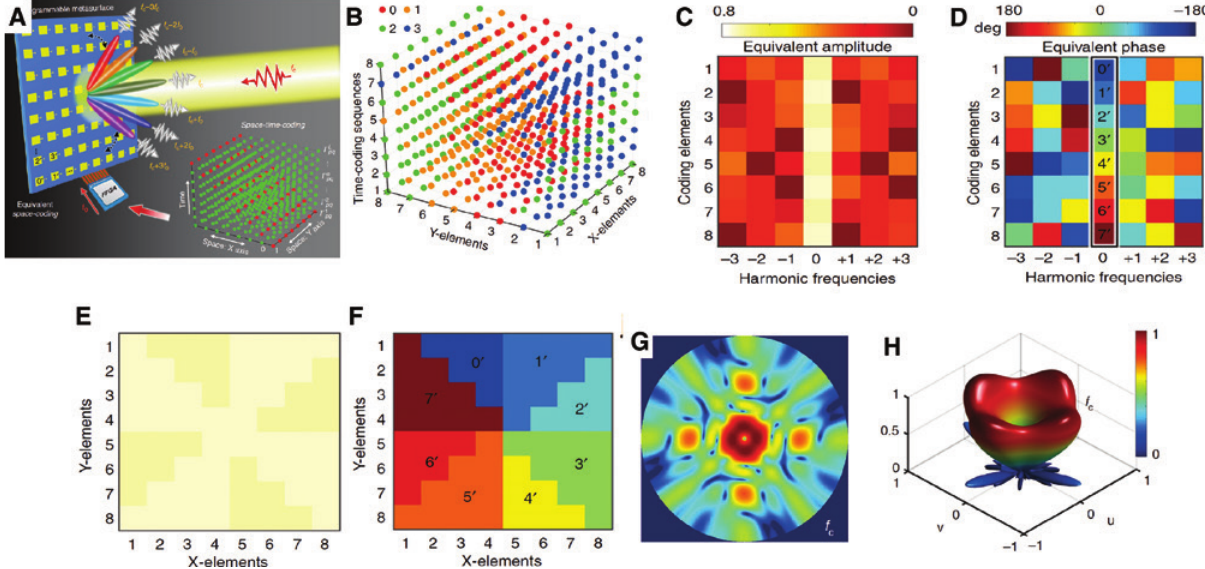
Figure 11: The time-space-coding information metasurface and its performance. (A) The conceptual illustration of a space-time-coding information metasurface. The reflection coefficients of the metasurface elements are dynamically controlled by changing the voltages to PIN diodes. Here, the reflection phase of each element is periodically switched according to the digital “0/1” space-time-coding matrix, which can result in an equivalent multi-bit space-coding, such as “0 ′ ,” “1 ′ ,” “2 ′ ” and “3 ′ ” (equivalent 2-bit case). (B) The space-time-coding matrix, (C)–(D) Equivalent amplitude and phase distributions at different harmonic frequencies, respectively. This space-time-coding matrix results in equivalent 3-bit coding responses “0,” “1 ′ ,” “2 ′ ,” “3 ′ ,” 4 ′ ,” “5 ′ ,” “6 ′ ” and “7 ′ ” at the central frequency. (E)–(F) The equivalent amplitude and phase distributions for vortex-beam generation at the central frequency, which exhibit an equivalent 3-bit coding spiral phase profile. (G)–(H) The corresponding 2D and 3D scattering patterns at the central frequency for beam shaping, respectively. Adapted from